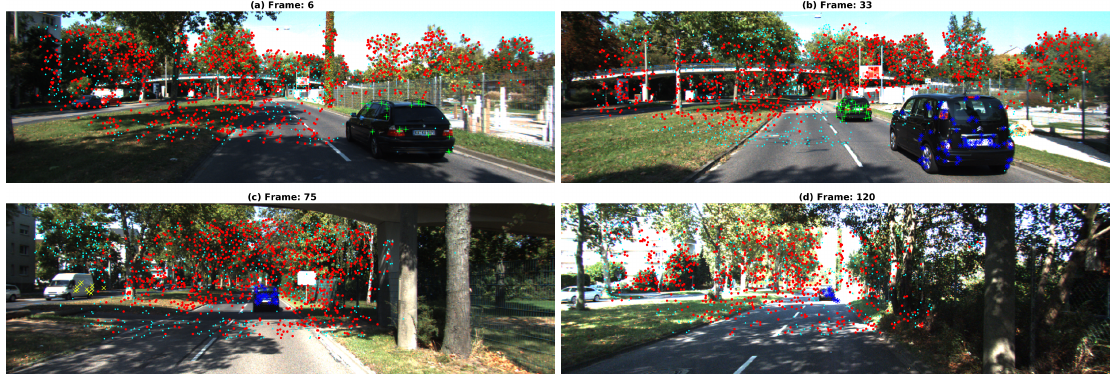
Figure 23. TbD-SfM results for Scene 7. The motions segmented are indicated by colors and markers. Red points represent the ego-motion. The 1st, 2nd and 3rd motion are represented by the green plus signs, blue asterisk and yellow cross respectively.